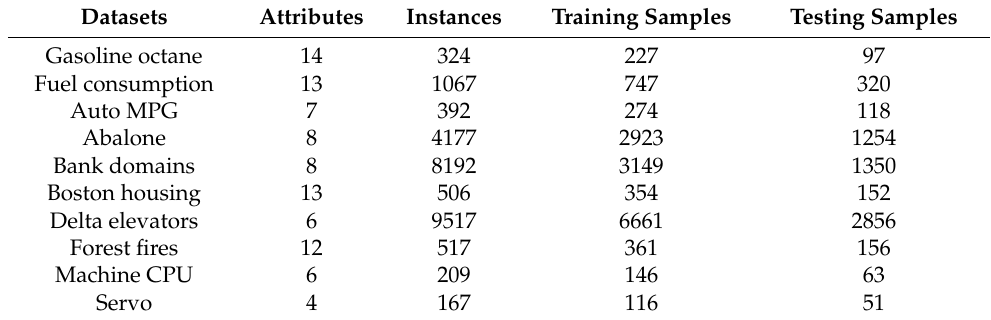
Table 1. Description of regression data sets.